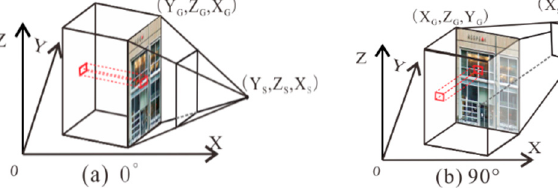
Figure 6. Orthorectification method for the building facade through 4 different directions. ( a ) Or- thorectification for a building facade in 0° direction; ( b ) orthorectification for a building facade in 90° direction; ( c ) orthorectification for a building facade in 180° direction; ( d ) orthorectification for a building facade in 270° direction.